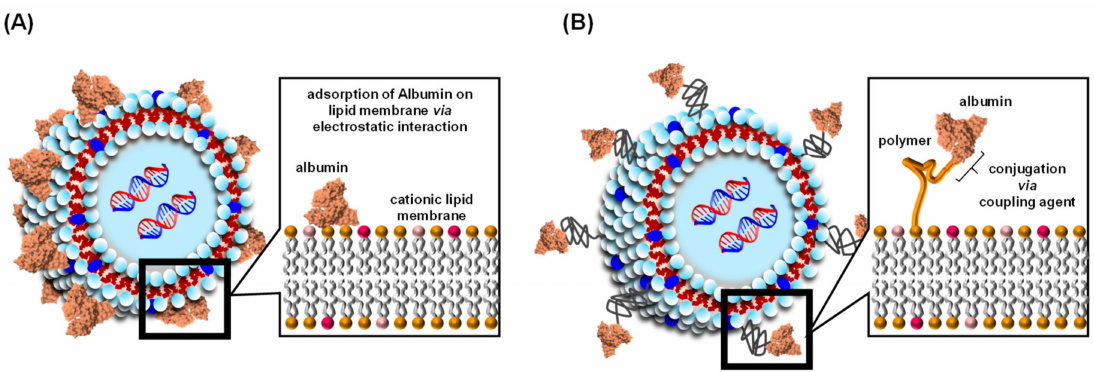
Figure 2. Schematic structure of the liposome coated albumin via electrostatic interaction ( A ) and conjugation using coupling agent ( B